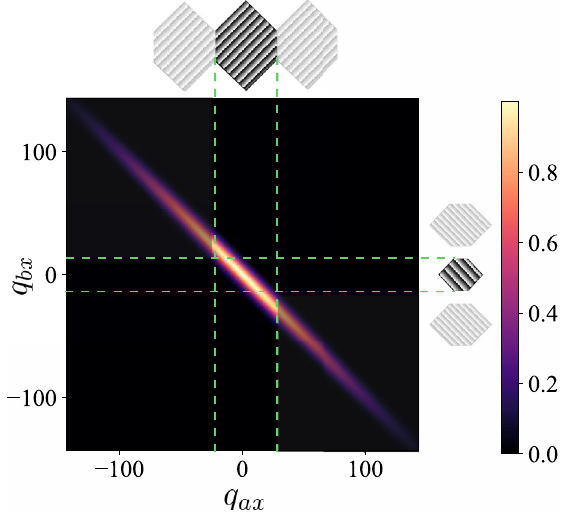
FIG. 7. Optimization of one-sided heralding efficiency. The one-sided heralding efficiency, or the probability that detecting a photon at the trusted party (Bob) heralds the presence of a photon at the untrusted party (Alice), can be optimized from knowledge of the two-photon JTMA [54]. The size of Bob ’ s hex pixels can be set in such a manner that the probability of coincidence counts between Alice and Bob is increased while the probability of single counts at Bob is decreased, effectively increasing the one- sided heralding efficiency η at